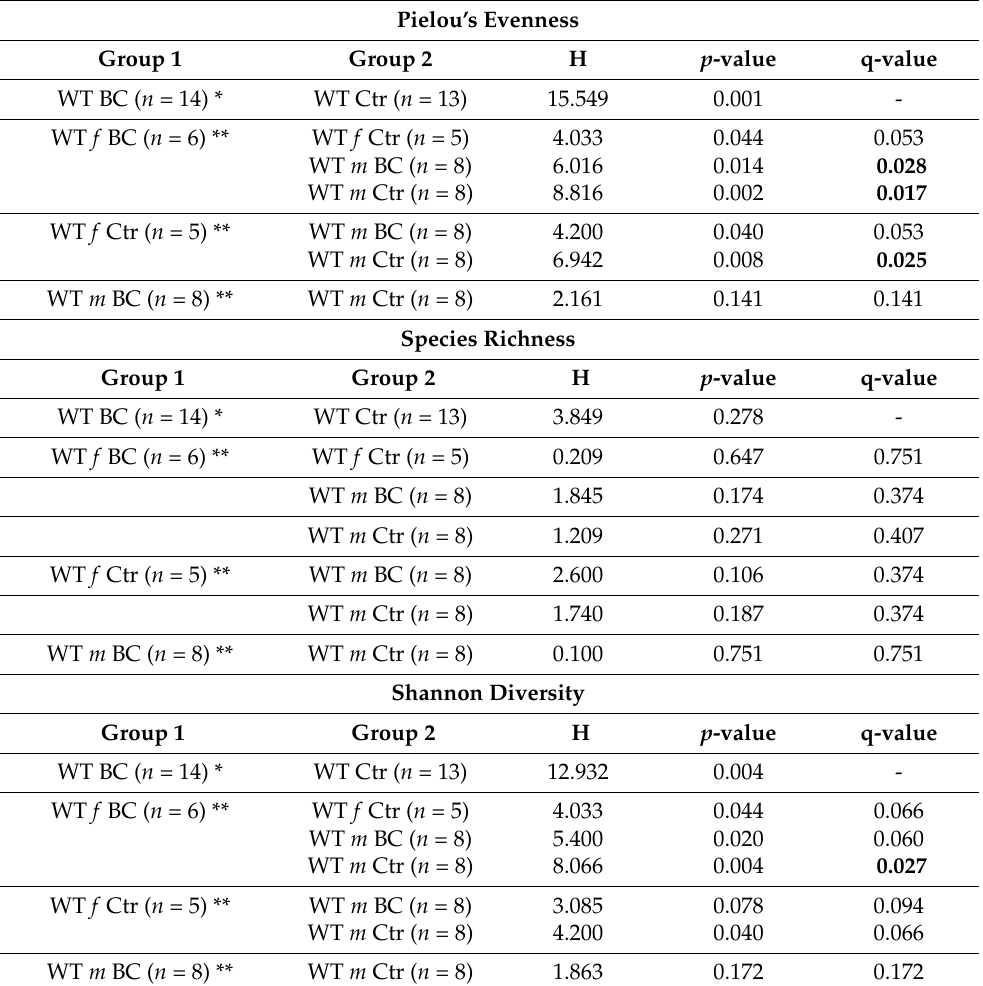
Table 1. Alpha diversity of the intestinal microbiota in WT mice post BC treatment. Quantified using Pielou ´ s evenness, species richness, and Shannon diversity indexes, which relate OTU richness and evenness, the total number of observed species, and variation and complexity within the group. Alpha diversity analysis performed with Kruskal–Wallis rank-sum and pairwise tests. WT = wild- type mice; BC = bovine colostrum treatment; Ctr = control mice; f = female; m = male; n = number of mice in each group. Pielou’s Evenness Group 1 Group 2 H p